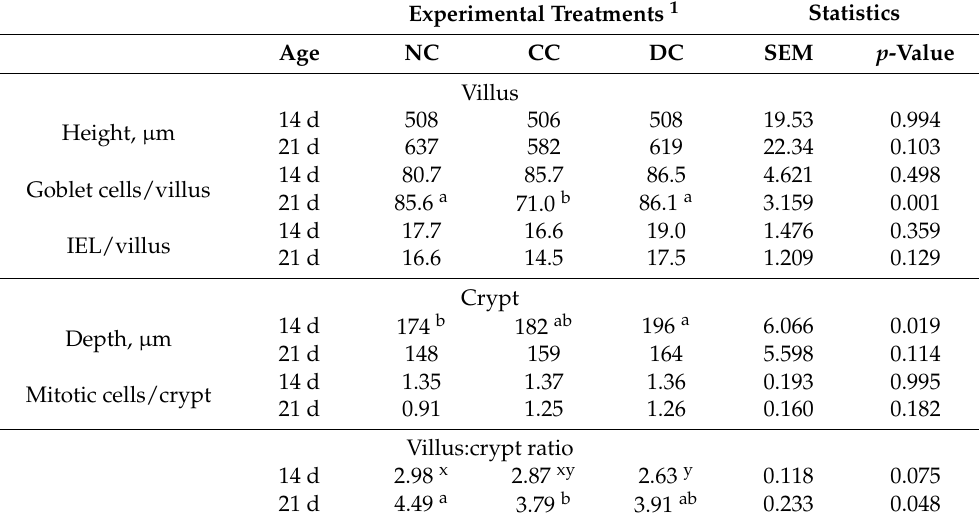
Table 9. Effects of treatments on histomorphological ileal parameters at 7 and 14 days post-inoculation with the coccidial inoculum (Experiment